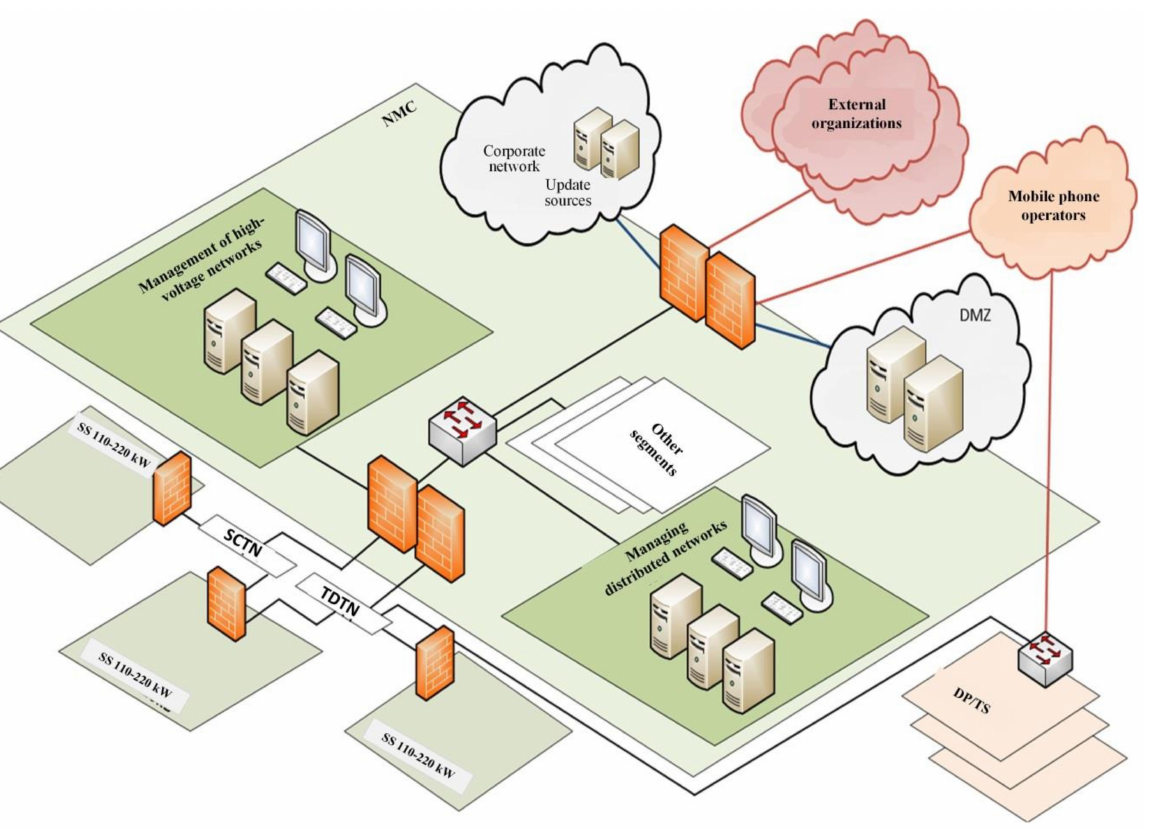
Figure 15. Functional diagram of the metropolitan SMART